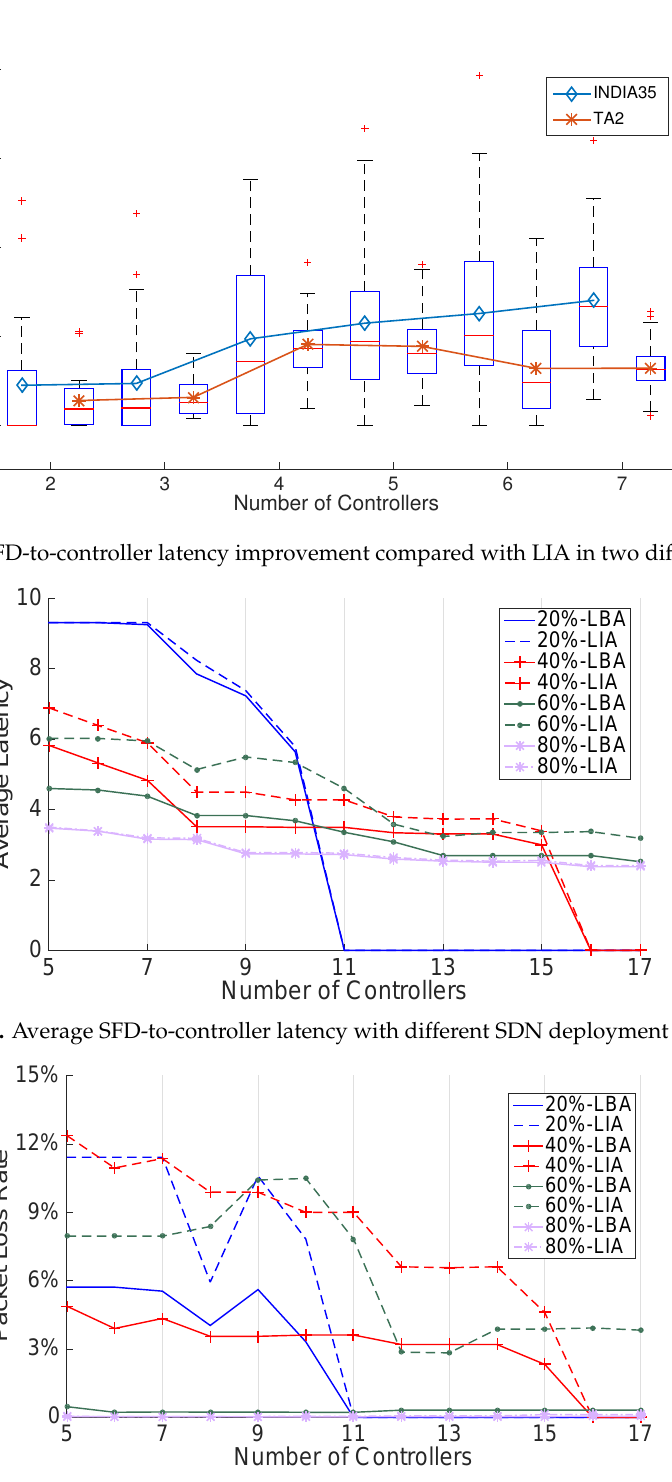
Figure 10. Loss rate with different SDN deployment